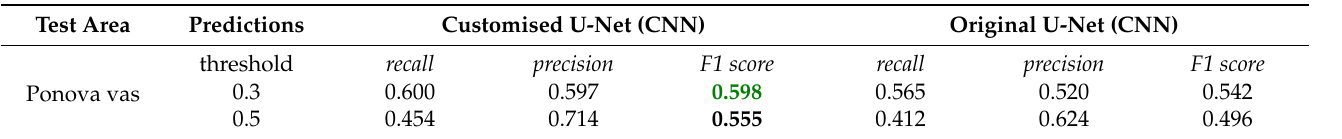
Table 3. Assessment of the detection quality of visible land boundaries and comparison of approaches—Ponova vas.